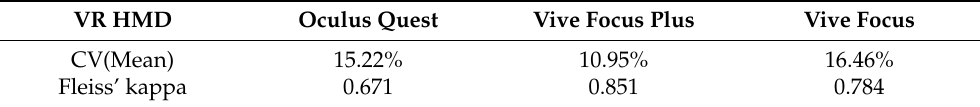
Table 2. Mean value of inter-observer variability for VR